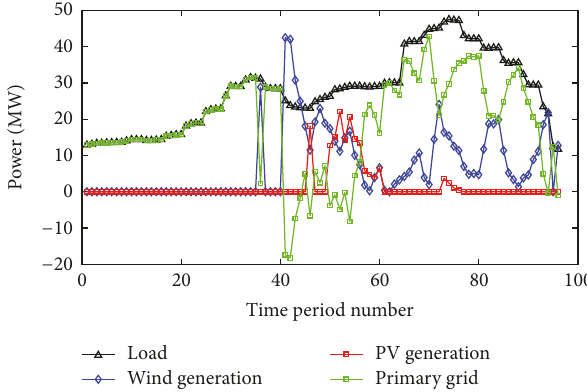
Figure 5: Power dispatching in good contamination-diffusing weather